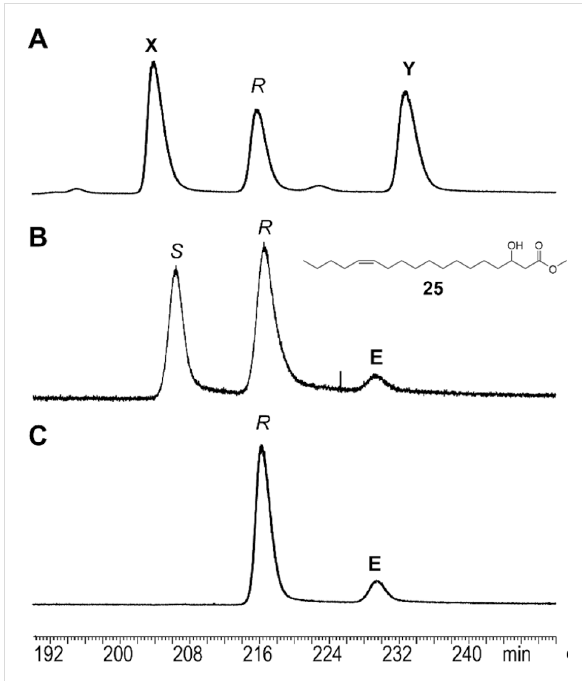
Figure 6: Separation of the enantiomers of methyl ( Z )-3-hydroxy-13- octadecenoate ( 25 ) on a β -6-TBDMS hydrodex gas chromatographic phase. A) Natural extract; B) synthetic rac - 25 ; C) synthetic ( R )- 25 ; X : methyl 3-hydroxy-11-octadecenoate; Y : methyl 3-hydroxyoctade- canoate; E : ( E )-isomer of ( R )- 25. The enantiomer ( S,E )- 25 elutes together with ( R , Z )- 25 , indicated by the broader base of this peak in B compared to